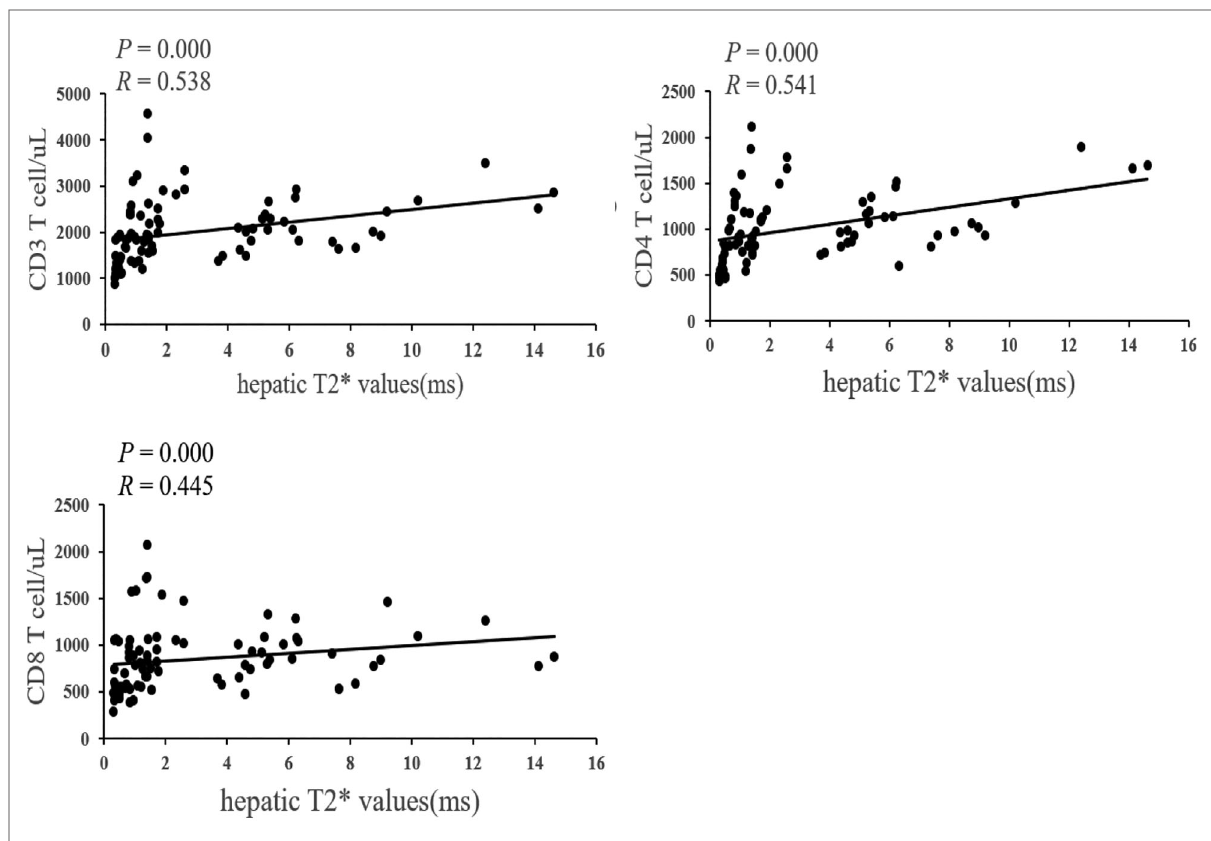
FIGURE 1 Correlation between hepatic T2* values and CD3, CD4, CD8 cells..